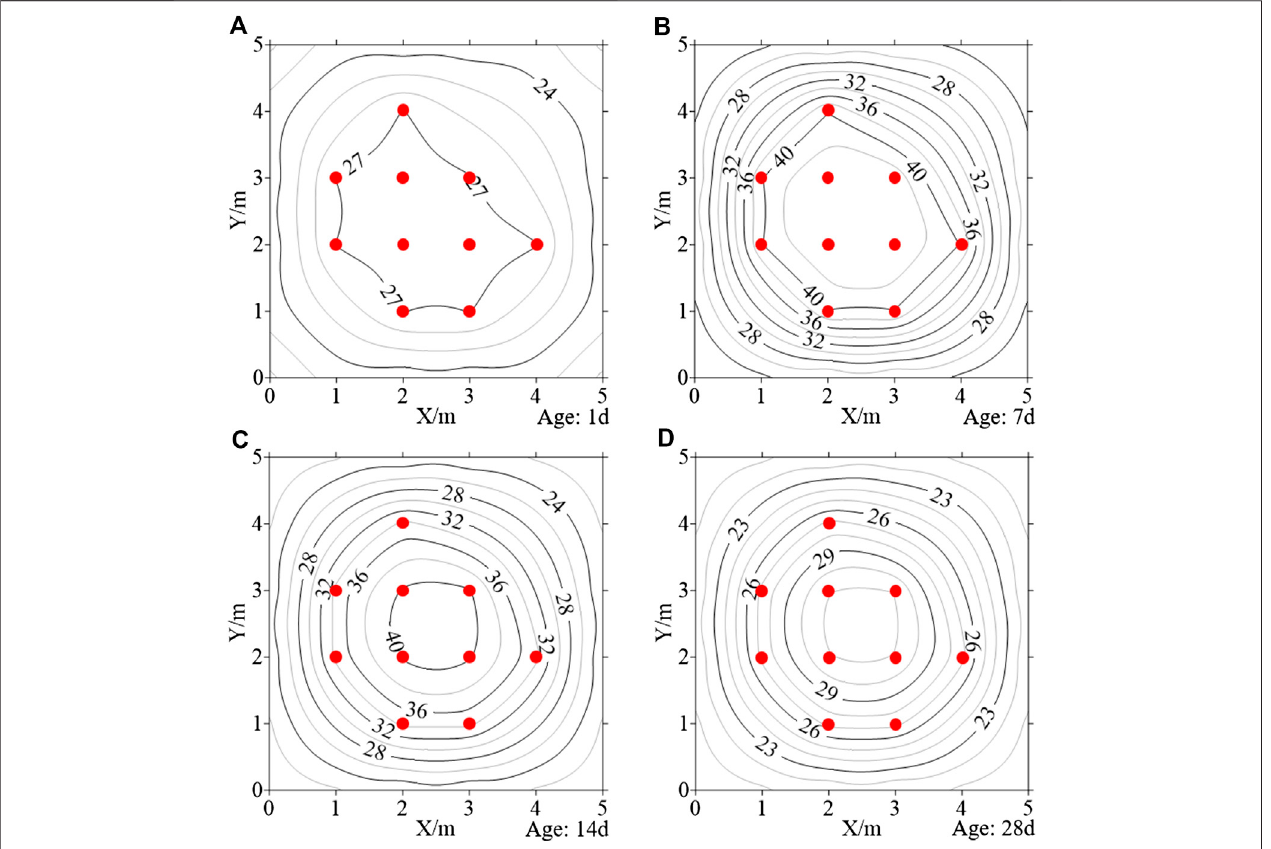
FIGURE 4 | The restructured thermal fi eld of the concrete block based on m (cid:2) 10: (A) 1 day; (B) 7 days; (C) 14 days; (D) 28 days (the red points represent temperature sensors).